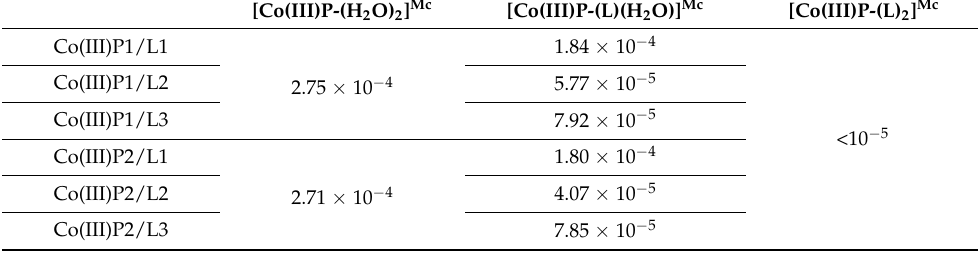
Table 5. Reduction rate constants of [Со(III)P-(H 2 O) 2 ] Mc , [Со(III)P-(L)(H 2 O)] Mc , and [Со(III)P-(L) 2 ] Mc into [Со(II)P] Mc in